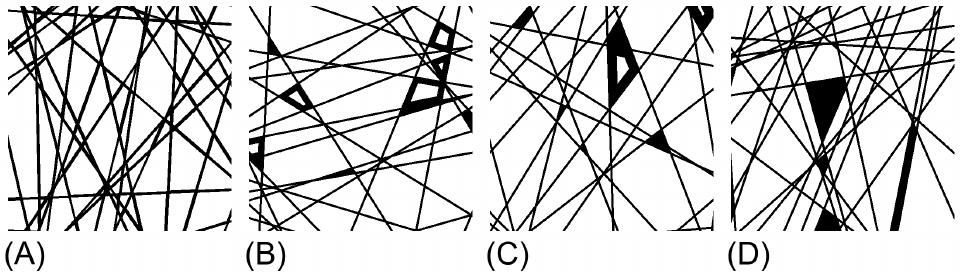
Figure 3. Binder applied to fiber representations using four different radii b r : ( A ) b r = 6 µm, ( B ) b r = 18 µm, ( C ) b r = 30 µm, and ( D ) b r = ∞